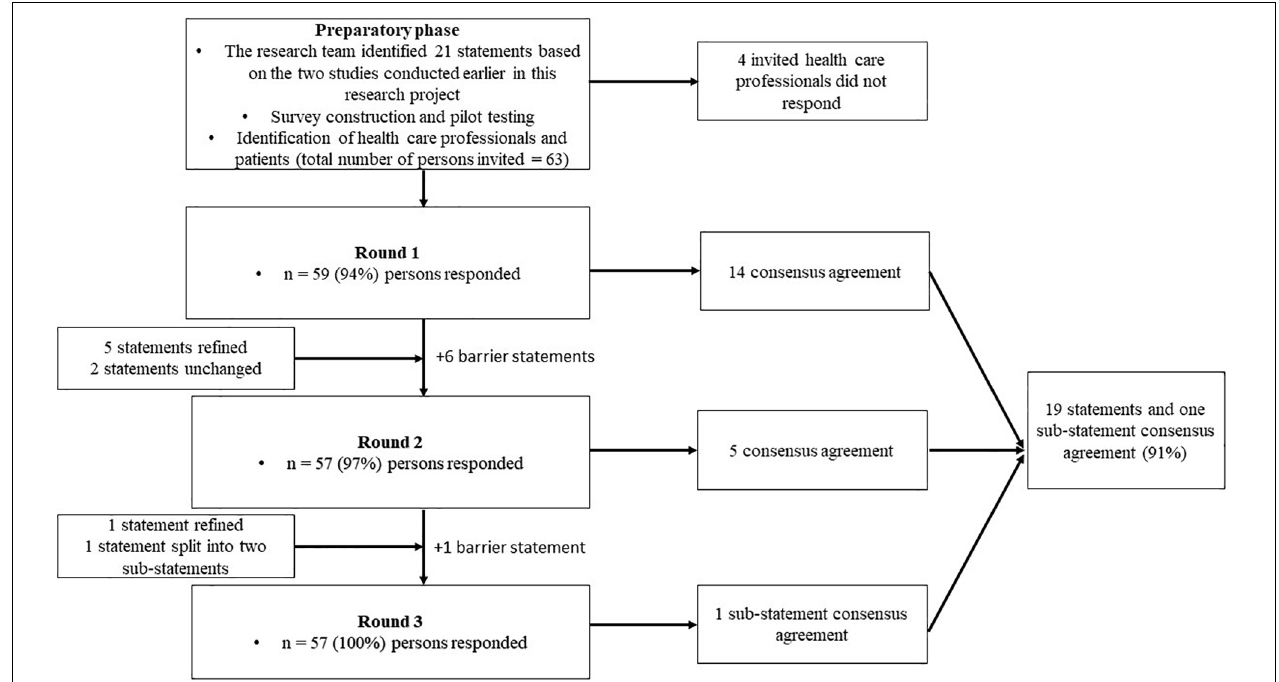
FIGURE 1 | Graphic representation of the modified Delphi